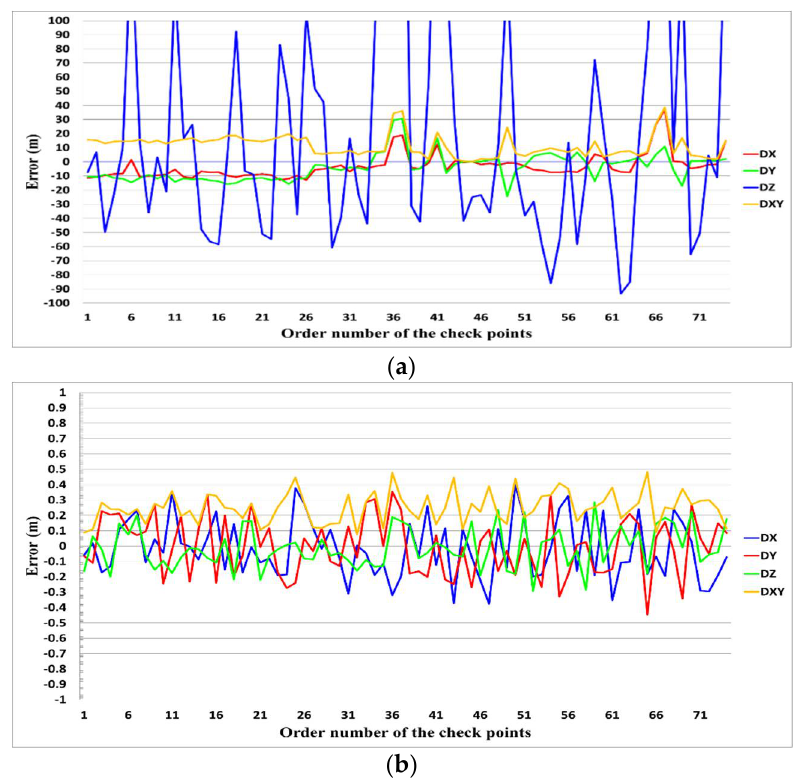
Figure 9. Errors of the check point (data I): ( a ) before the iterative calculations; ( b ) after the iterative calculations. Table 3. Error statistics before and after the iterative calculations of the registration (Unit: m).